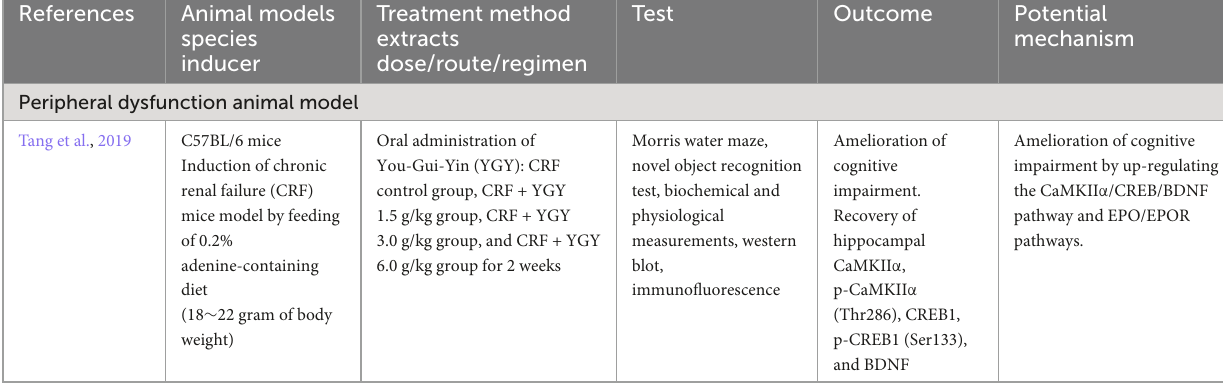
immune systems that occur in peripheral organs play an important role in the expression of cognitive impairments such as